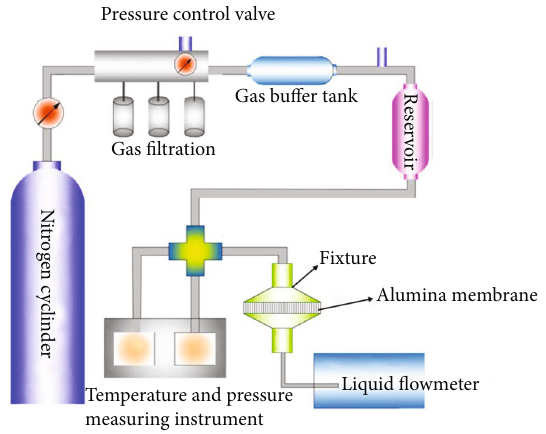
Figure 4: Micro- and nanochannel experiment system chart